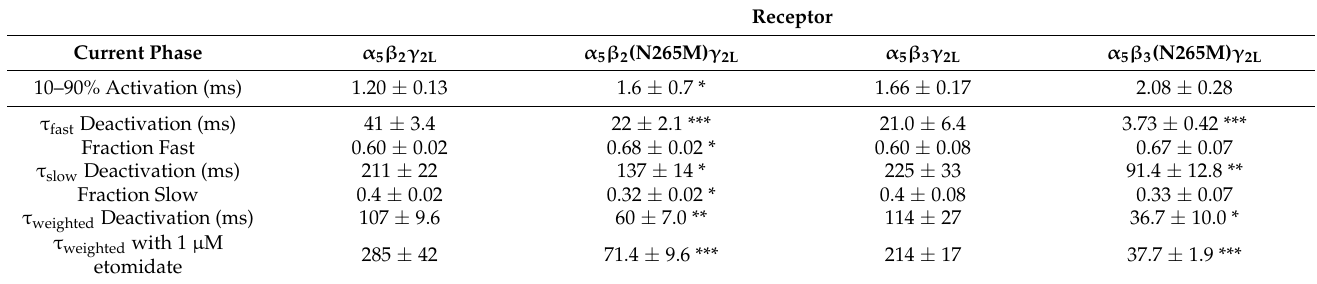
Table 1. Activation and Deactivation Kinetics in GABA-stimulated Wild-Type and β 2/3-N265M Re-